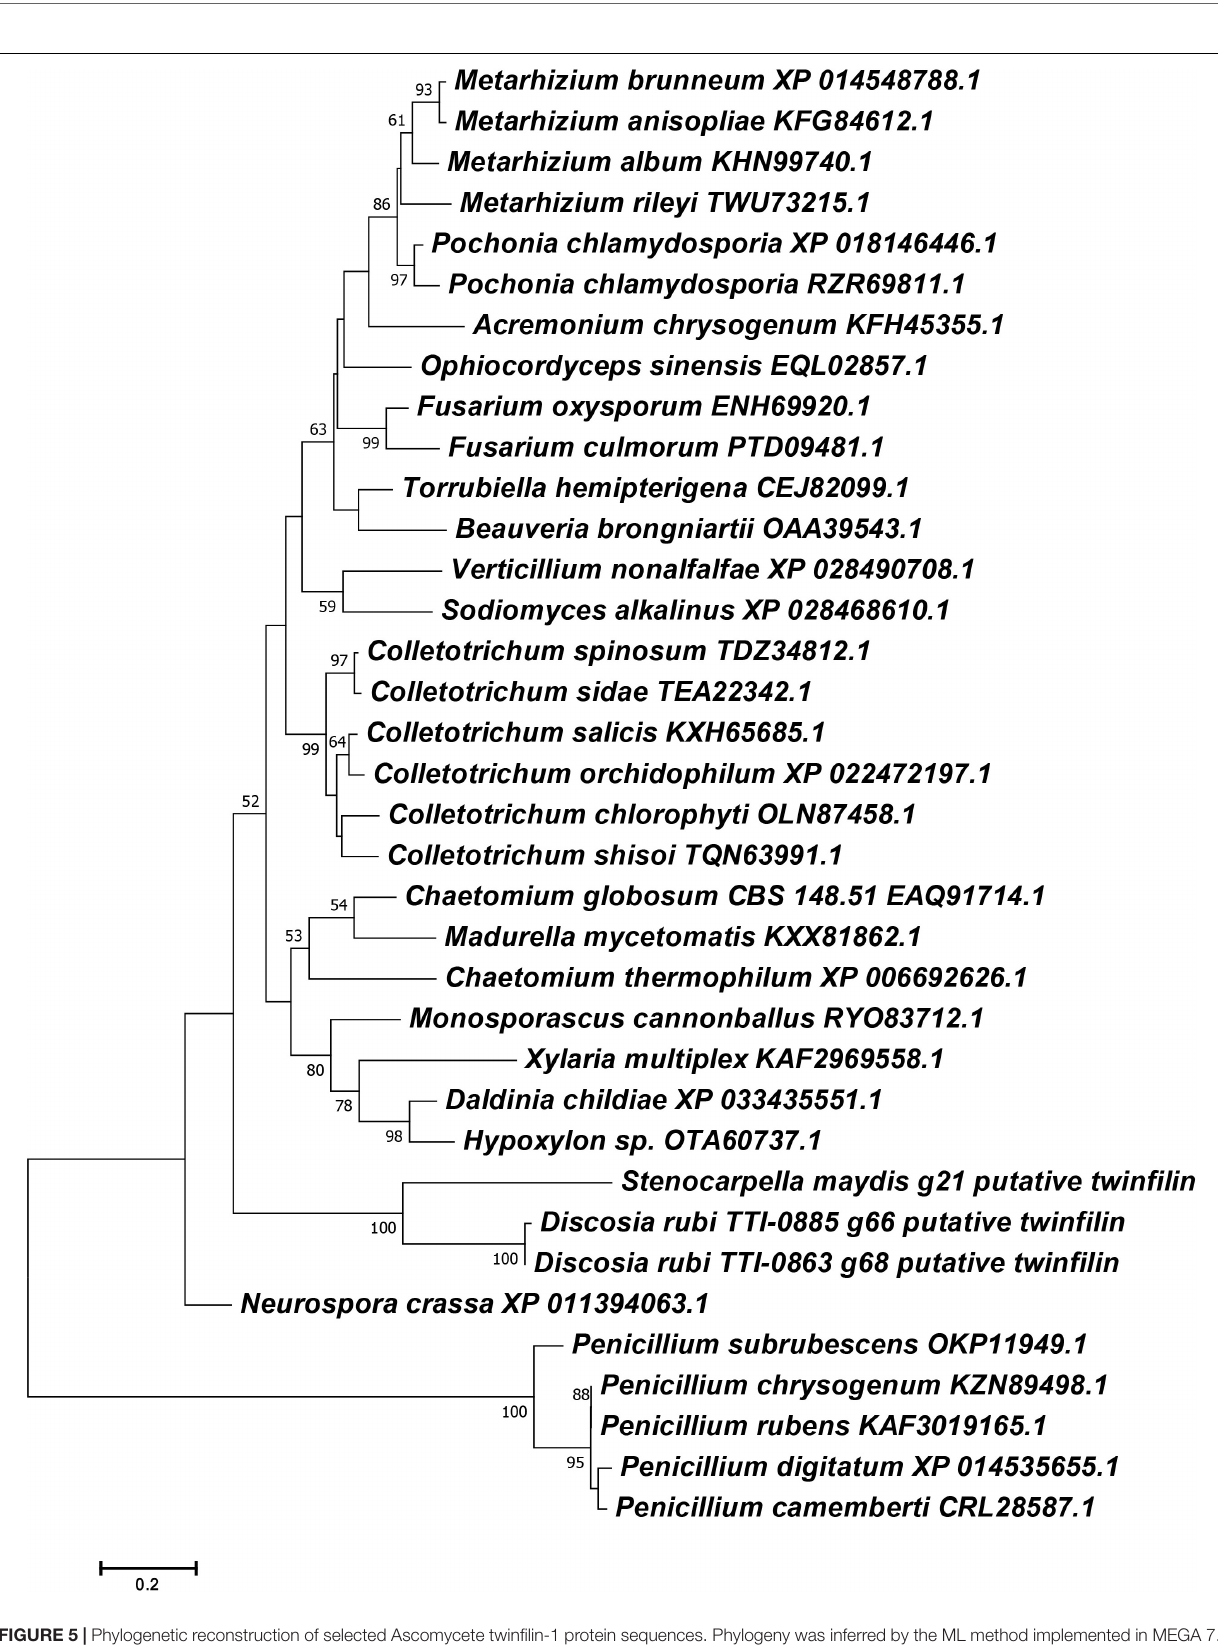
Frontiers in Microbiology |